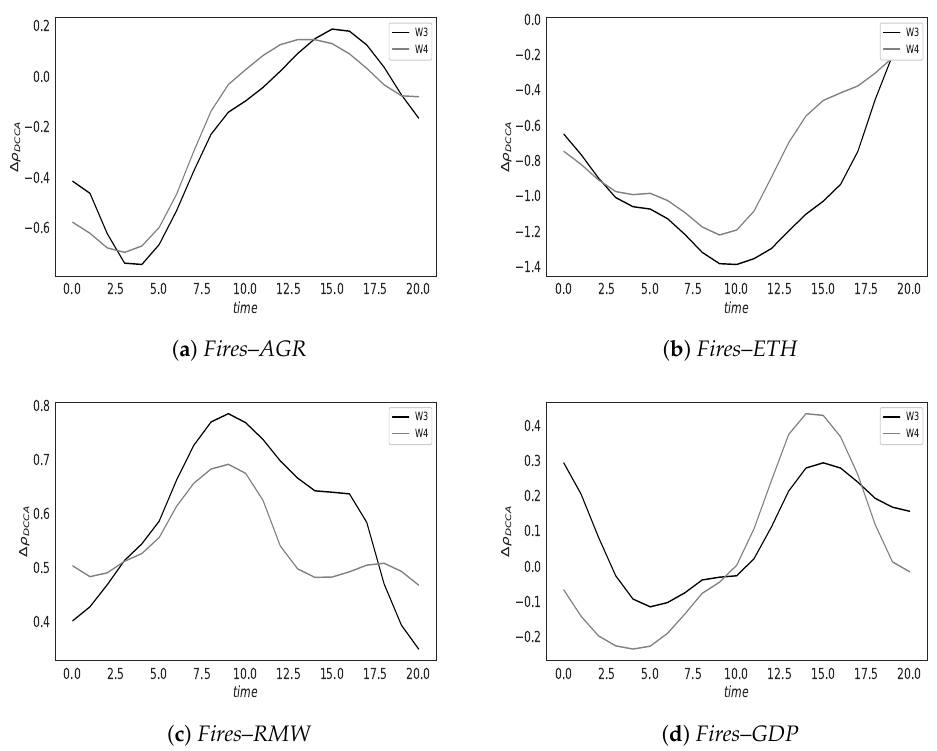
Figure A6. The ∆ ρ dcca for the different TS pairs and time scale n = 10.